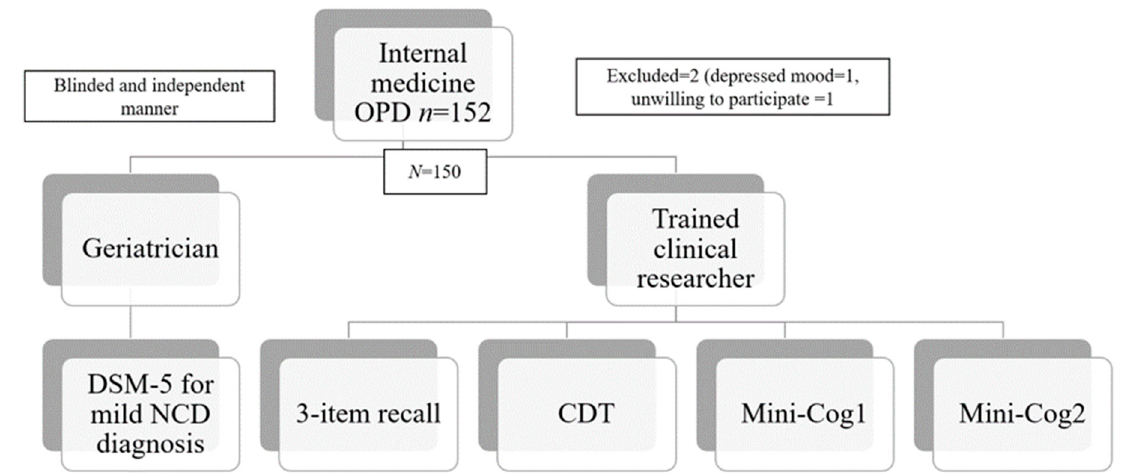
Figure 1. Study flow. Note: DSM-5, Diagnostic and Statistical Manual of Mental Disorders; mild NCD, mild neurocognitive disorder.